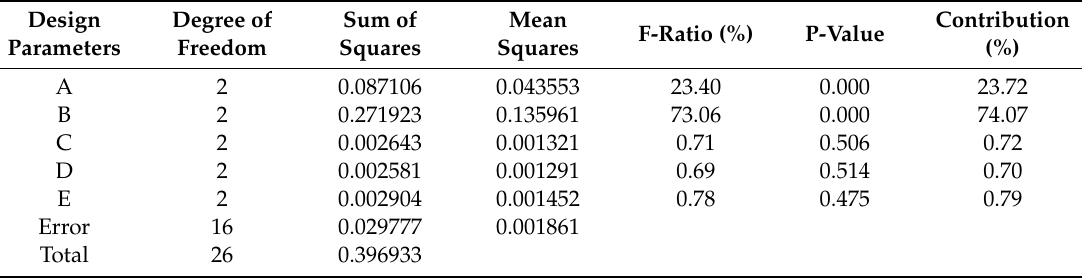
Table 6. Analysis of variance for shrinkage in the flow